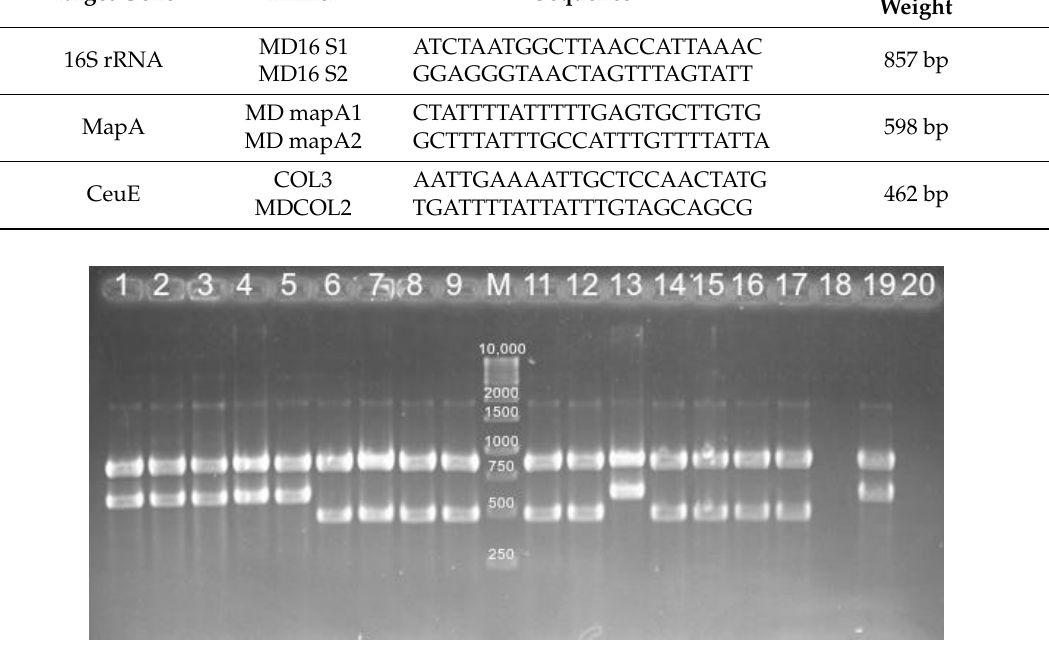
Figure 1. Identification of Campylobacter by multiplex PCR. M: Marker (O’ Gene Ruler 1kb